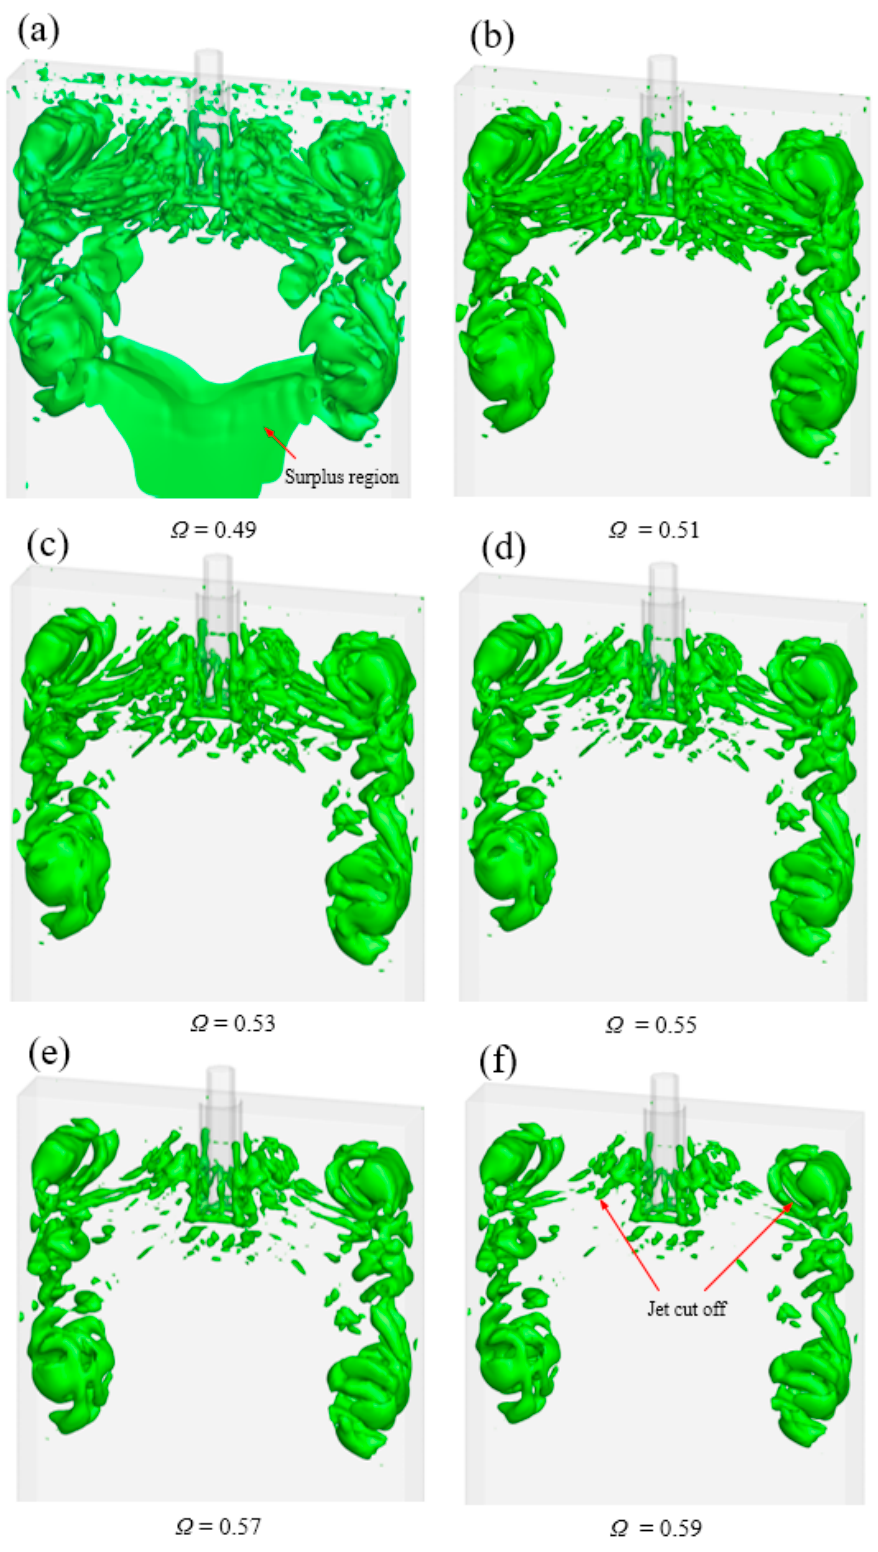
Figure 14. Vortex structures of the upper and lower streams near the wall using the Ω criterion of the thresholds of ( a ) 0.49, ( b ) 0.51, ( c ) 0.53, ( d ) 0.55, ( e ) 0.57, and ( f ) 0.59.